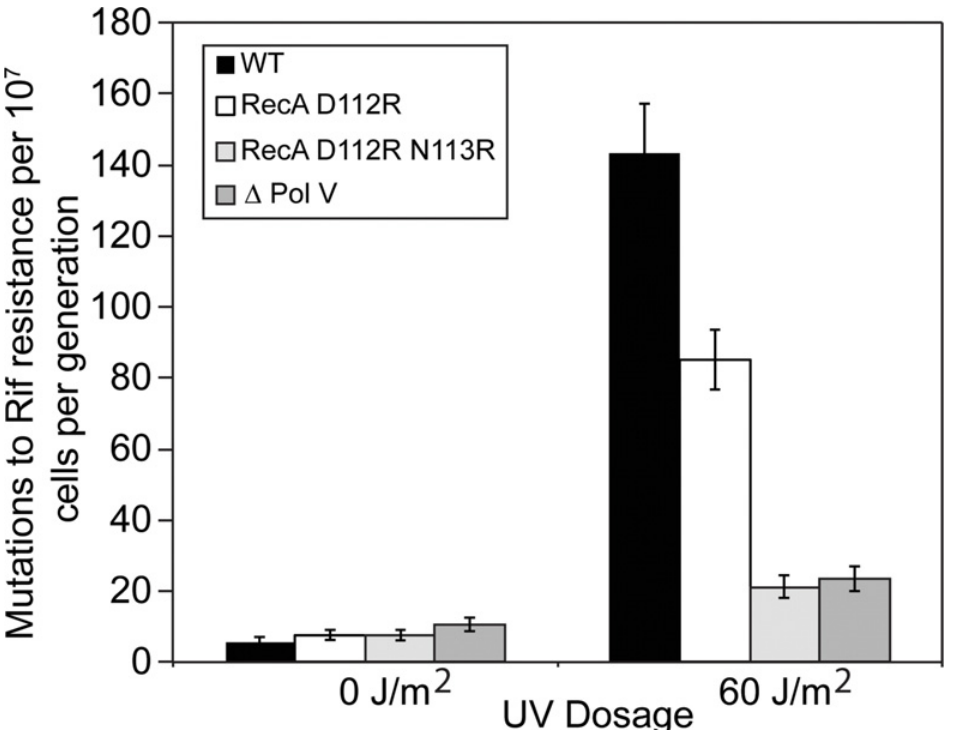
Fig 2. The RecA D112R N113R variant reduces SOS mutagenesis to levels comparable to strains lacking DNA polymerase V. The majority of rifampicin resistant colonies are dependent upon pol V SOS mutagenesis. A rifampicin mutation assay was used to determine mutation rate from 15-tube fluctuation analyses, and 95% confidence limits were calculated as described in Methods. All strains were derived from MG1655. Briefly, cells were grown to mid-log and exposed to 0 J/m 2 or 60 J/m 2 to induce SOS, grown overnight at 37°C, and plated on Rifampicin and LB plates. Colony counts were performed followed by fluctuation